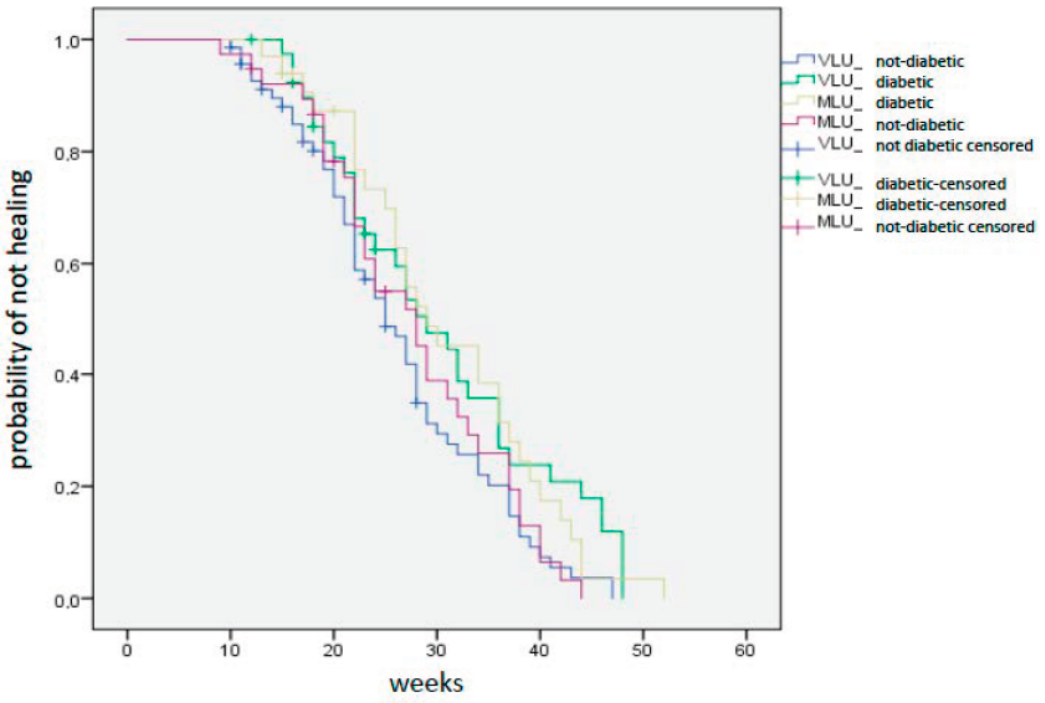
Figure 3. Venous Leg Ulcers and Mixed Leg Ulcers survival curves in diabetic and not diabetic patients.